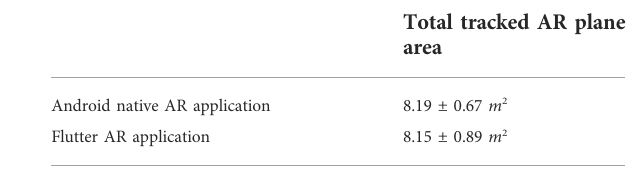
TABLE 7 Plane tracking quality